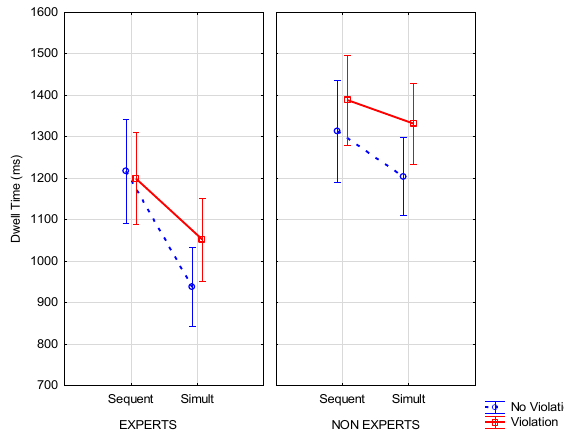
Figure 8. Dwell time (ms) according to expertise, note modification and presentation (error bars represent standard error).